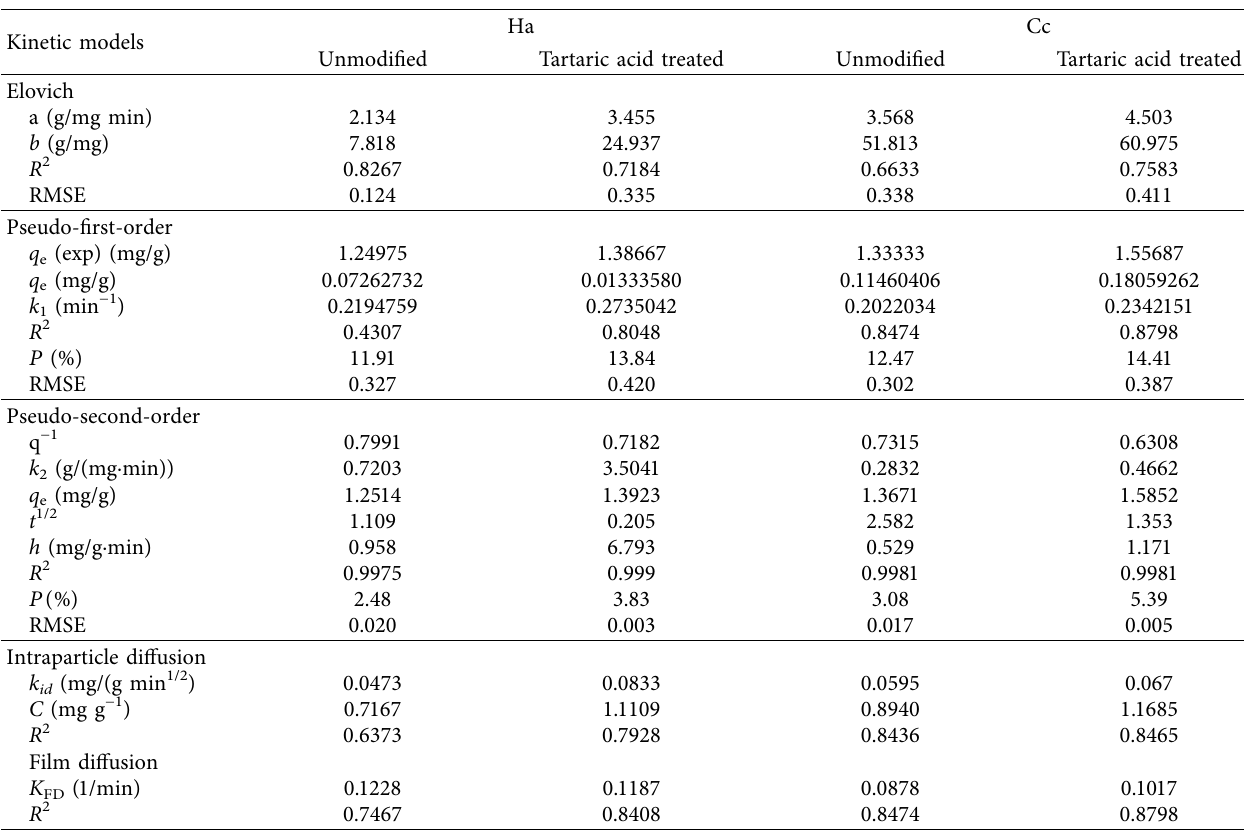
Table 2: Kinetic parameters for BG dye